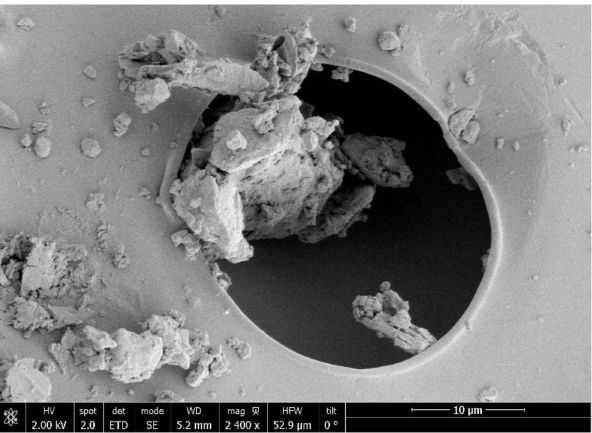
Figure 13. Rutin trapped in one of the pores of the foam obtained (Run